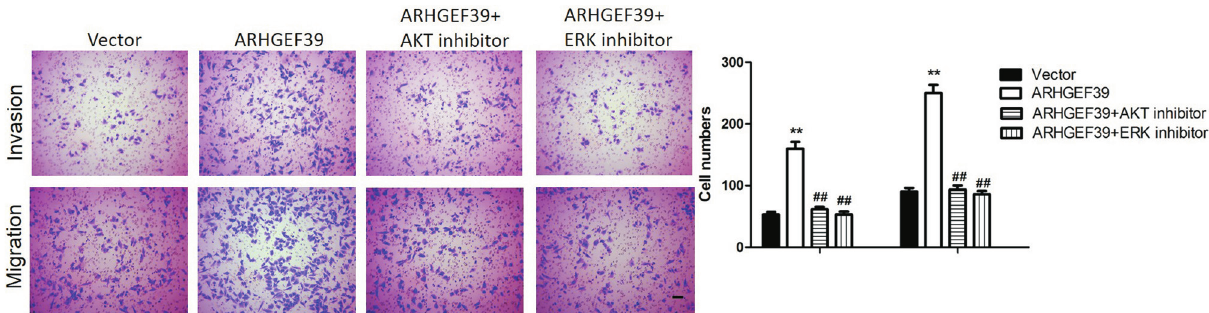
Figure 5 - Effect of ARHGEF39 on the expression levels of p-AKT and p-ERK protein in ccRCC cells. A) Effect of ARHGEF39 on the expression levels of p-AKT and p-ERK protein in Caki-1 cells with down-regulated ARHGEF39, **p < 0.01. B) Effect of ARHGEF39 on the expression levels of p-AKT and p-ERK protein in UT33A cells with up-regulated ARHGEF39, **p < 0.01.